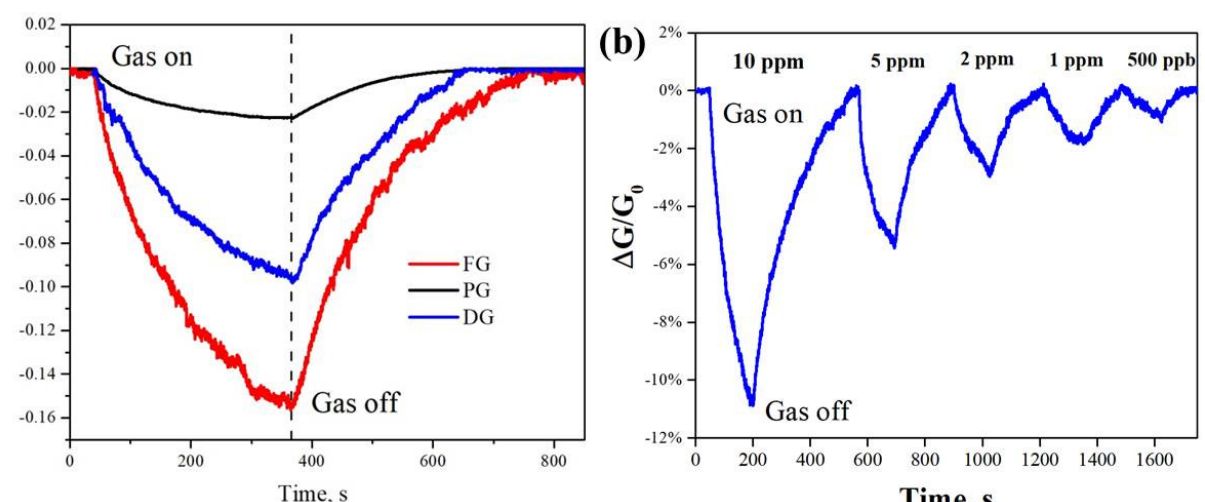
Figure 2. ( a ) Responses of PG, DG and FG to 10 ppm NH 3 with the same exposure time. ( b ) Re- sponses of FG devices under different concentration of NH 3 gas under ambient pressure. ( c ) Re- peatability of the FG device to 10 ppm of NH3 gas. ( d ) Responses of the PG and FG sensors to NH 3 and CO gases with a concentration of 10 ppm. 4. Discussion To better understand the gas physisorption kinetics, as well as the limitations re- garding detection, the NH 3 sensing experiment of the FG sample with various gas con- centrations was performed as shown in Figure 2d. The Langmuir isotherm model was applied to investigate the superior NH 3 gas sensing performance of the fluorinated gra- phene [42]. The Langmuir isotherm model can be applied for the FG gas sensing mecha- nism and is summarized by the following formula [43–45]: (cid:3017) (cid:3020) = (cid:3017) (cid:3020) (cid:3116) + (cid:2869) (cid:3012)(cid:3020) (cid:3116) ,